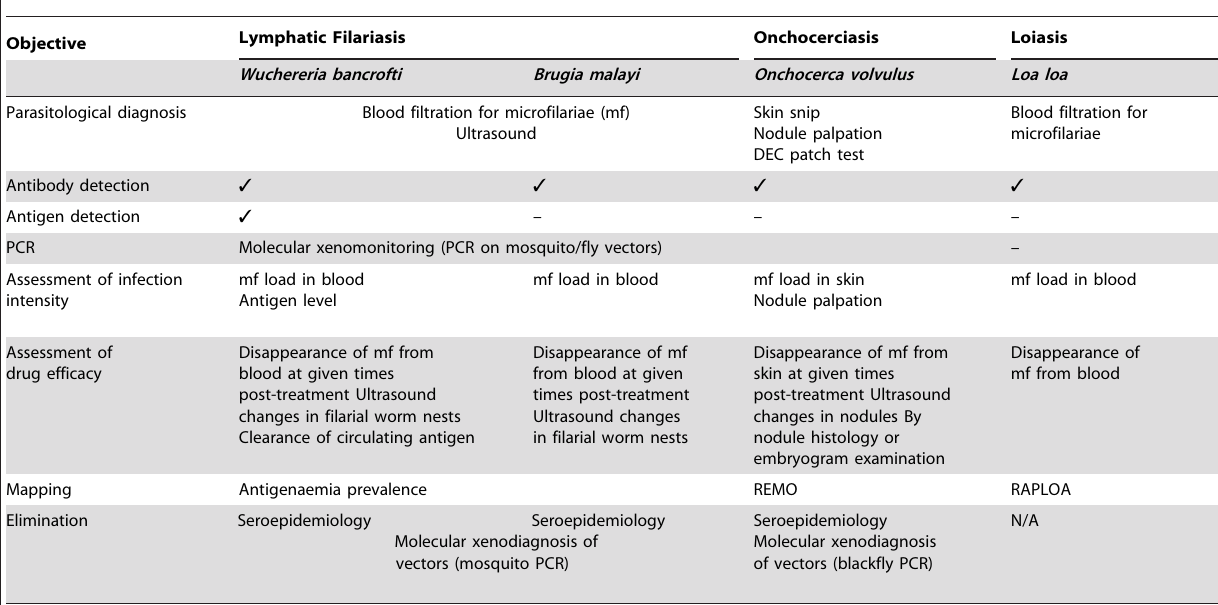
Table 3. Diagnostics Available for Filarial Infections.